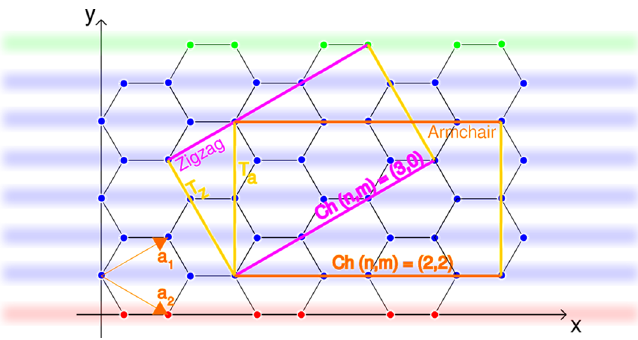
→ → Figure 4. Vectors 𝒂 𝟏 (cid:4652)(cid:4652)(cid:4652)(cid:4652)⃗ and 𝒂 𝟐 (cid:4652)(cid:4652)(cid:4652)(cid:4652)⃗ represented graphically on the virtual graphene sheet, along with zigzag a 1 and a 2 represented graphically on the virtual graphene sheet, along with zigzag Figure 4. Vectors and armchair virtual graphene nanoribbons. and armchair virtual graphene